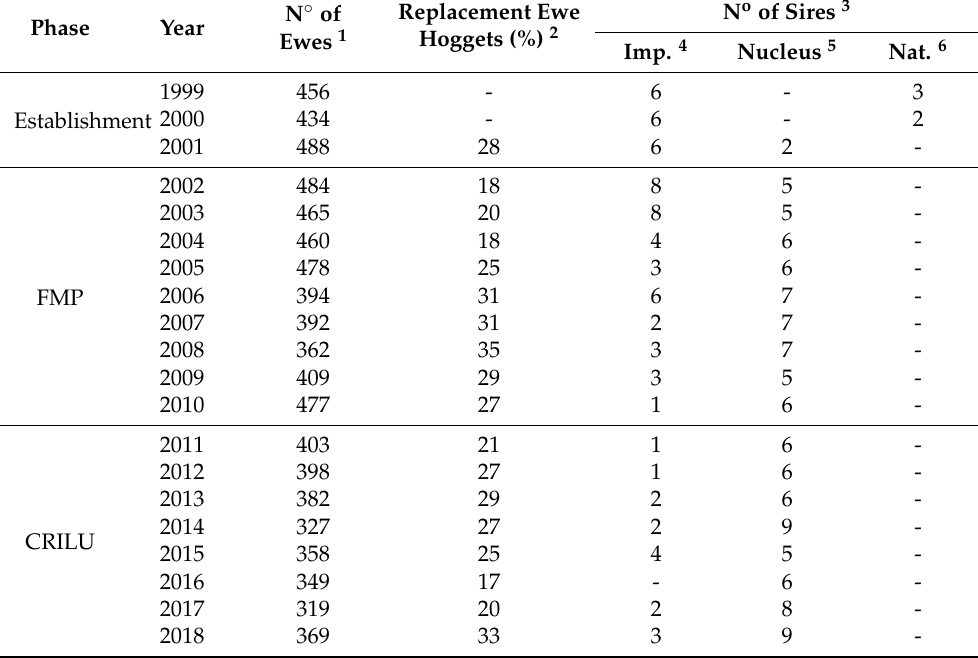
Table 1. Total annual number of ewes, percentage of ewe replacement by ewe hoggets and number of sires utilized in the fine Merino genetic nucleus over the entire study period